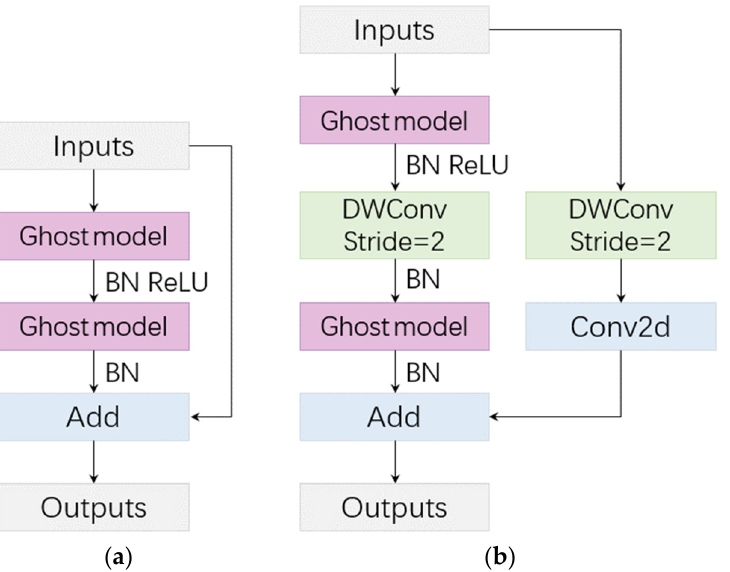
Figure 5. Ghost bottleneck structure . DWConv: depthwise separable convolution; BN: batch normalization. ( a ) Strides = 1; ( b ) Strides = 2.